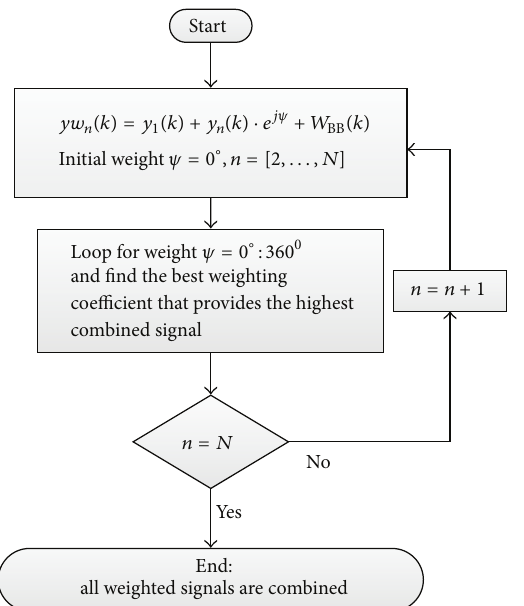
Figure 8: Received signal at base station from 4 transmitting